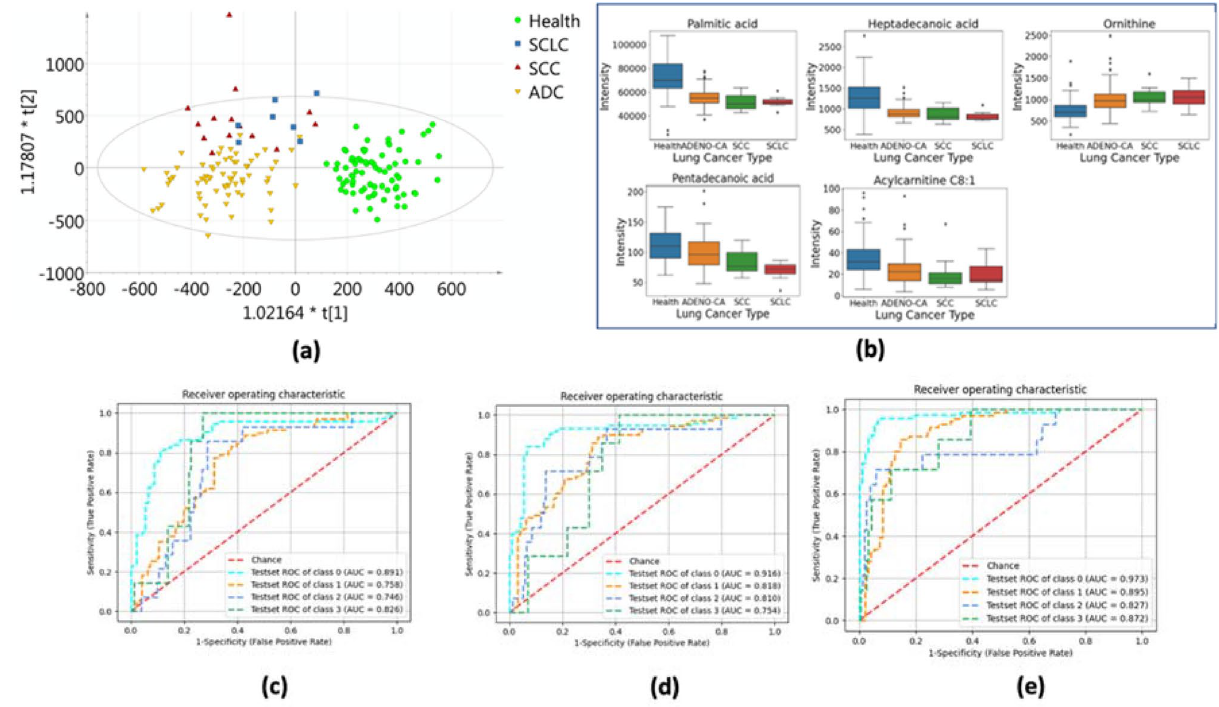
Figure 3. (a) Orthogonal projection on latent structure discriminant analysis (OPLS-DA) scores plot shows the ability to discriminate three lung cancer types and healthy controls. (b) Box and whisker plots for the top 5 most important metabolites between healthy control and different lung cancer types. (c)-(e) Receiver-operating characteristic (ROC) curves for discriminating lung cancer types, where class 0 represents healthy controls, class 1 represents adenocarcinomas, class 2 represents SCC lung cancer, and class 3 represents SCLC [(c) ROC curves of the logistic model using top 5 metabolomic markers; (d) ROC curves of the logistic model using top 10 metabolomic markers; (e) ROC curves of the logistic model using top 20 metabolomic